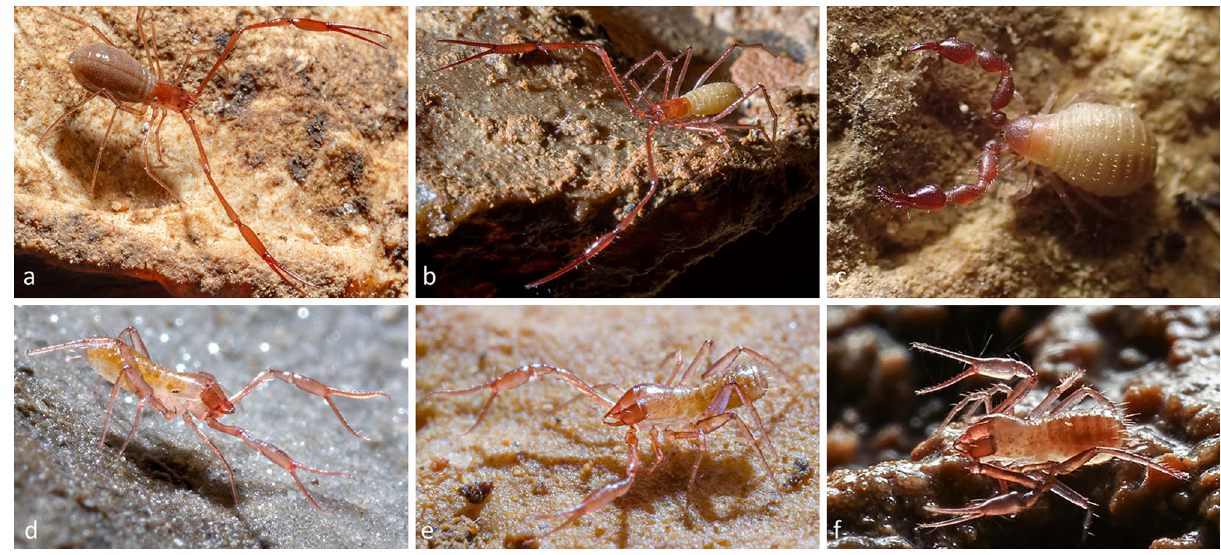
Figure 1. Life habitus of species within the most speciose families in the Dinaric Karst. ( a , b ) Neobisiidae Chamberlin, 1930; ( c ) Chernetidae Menge, 1855; ( d , e , f ) Chthoniidae Daday, 1889. Photos are courtesy of Petra Bregović ( a , b , d and e ), Branko Jalžić ( c ), and Tin Rožman ( f